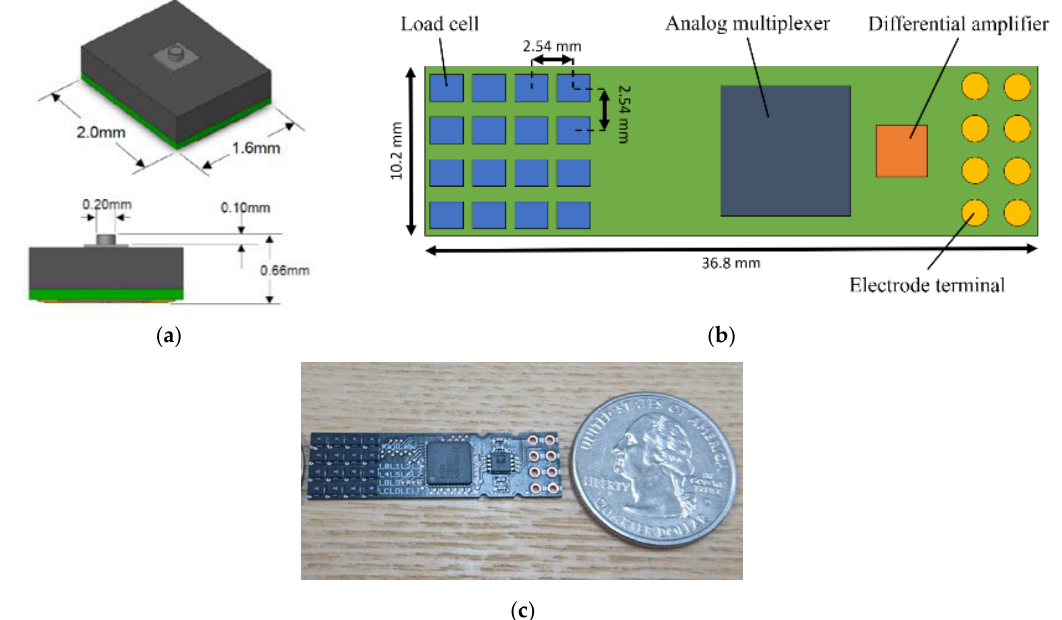
Figure 1. ( a ) Load cell used for pressure sensing. ( b , c ) Schematic and photo of sensor substrate comprising 4-by-4 load cells.